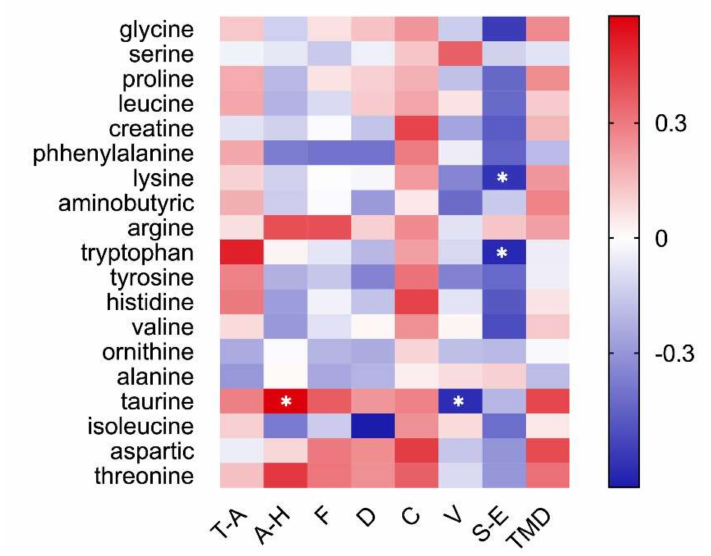
Figure 7. Correlation between subjective emotion and salivary metabolomics. Heat maps exhibit significant statistical correlation values (r). Red squares indicate positive correlation, white squares indicate no correlations, and blue squares indicates negative correlation. The deeper color means a greater correlation (* p < 0.05). Pearson’s correlation coefficient and regression analysis were per- formed to evaluate the connection between subjective emotional evaluation and saliva